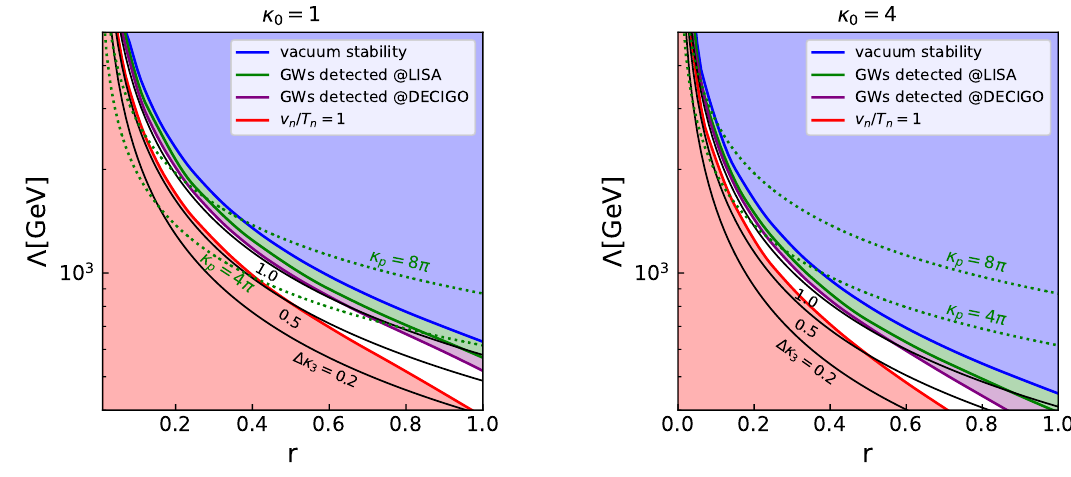
Figure 6 . Parameter space in which the GW will be detected at LISA (green) and DECIGO (purple). The color notation of the red and blue regions are same with figure 2. We take κ 0 = 1 and 4 in the left and right figure, respectively. The black lines are contours of ∆ κ 3 = κ 3 − 1 = 0 . 2 , 0 . 5 and 1